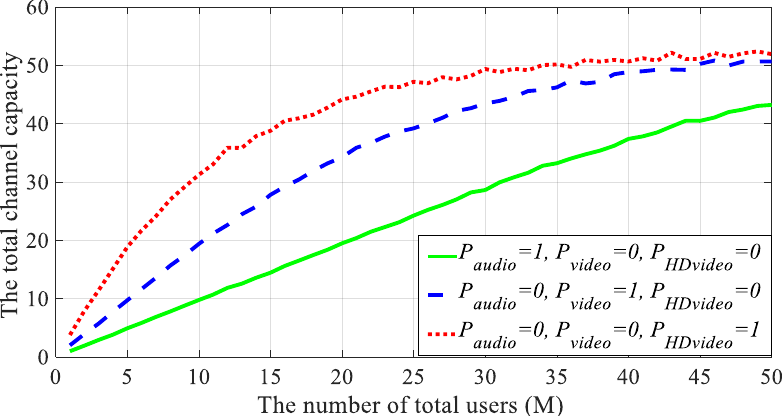
Figure 12. The total system channel capacity of the single relay-allowed modified pilot-based grouping method in scenario 3.